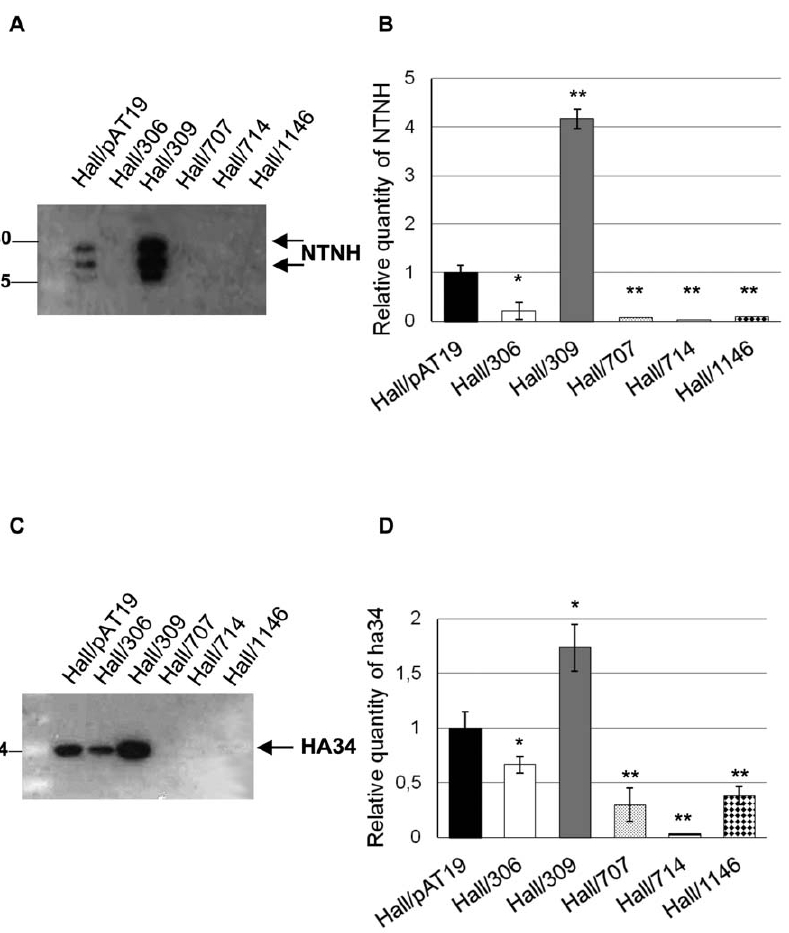
Figure 5. NTNH and HA34 production in Hall botR/A and 3 TCS isogenic antisense strains. Production of NTNH (A) and HA34 (B) was assayed by western blotting in 12 h culture supernatants of Hall/pAT19, Hall/306, Hall/309, Hall/707, Hall714, and Hall/1146. Western blots were quantified by ImageJ (B and D) with normalization of NTNH and HA34 production in Hall/pAT19 to 1. Data are mean values + / 2 SD from 3 independent experiments, *P , 0.05 and **P , 0.005.